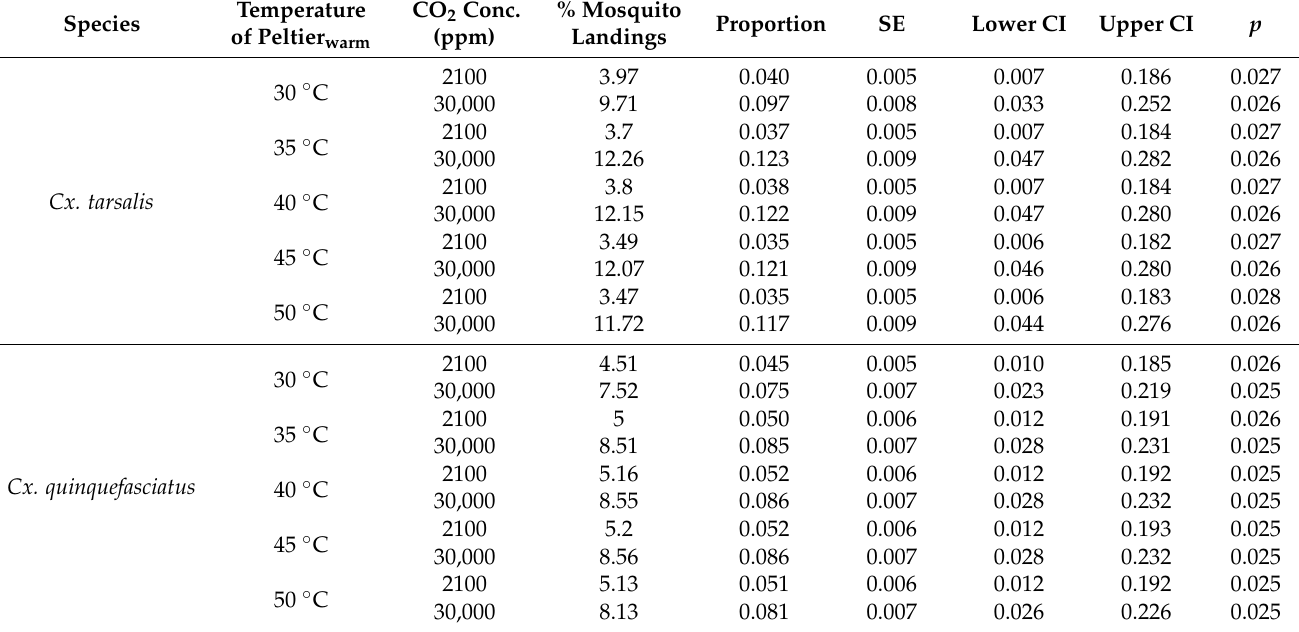
Table 1. Mosquito landings on Peltier warm in the heat-seeking assay.